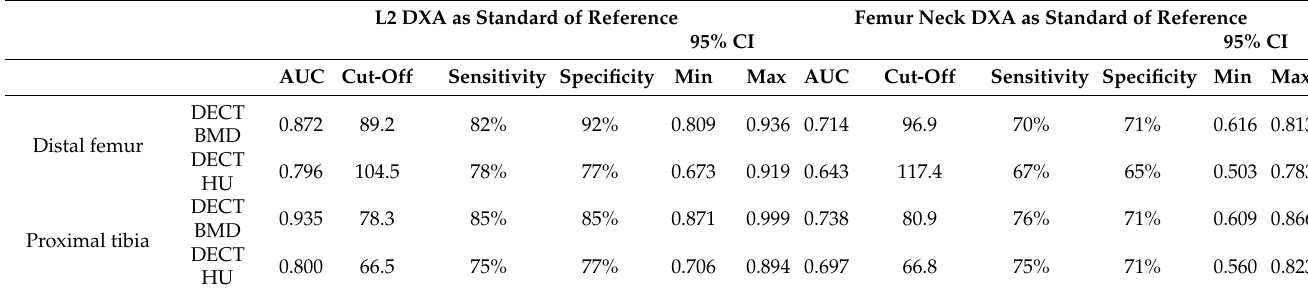
Table 3. Diagnostic accuracy of DECT BMD and HU for osteoporosis diagnosis in distal femur and proximal tibia using DXA as the reference standard.